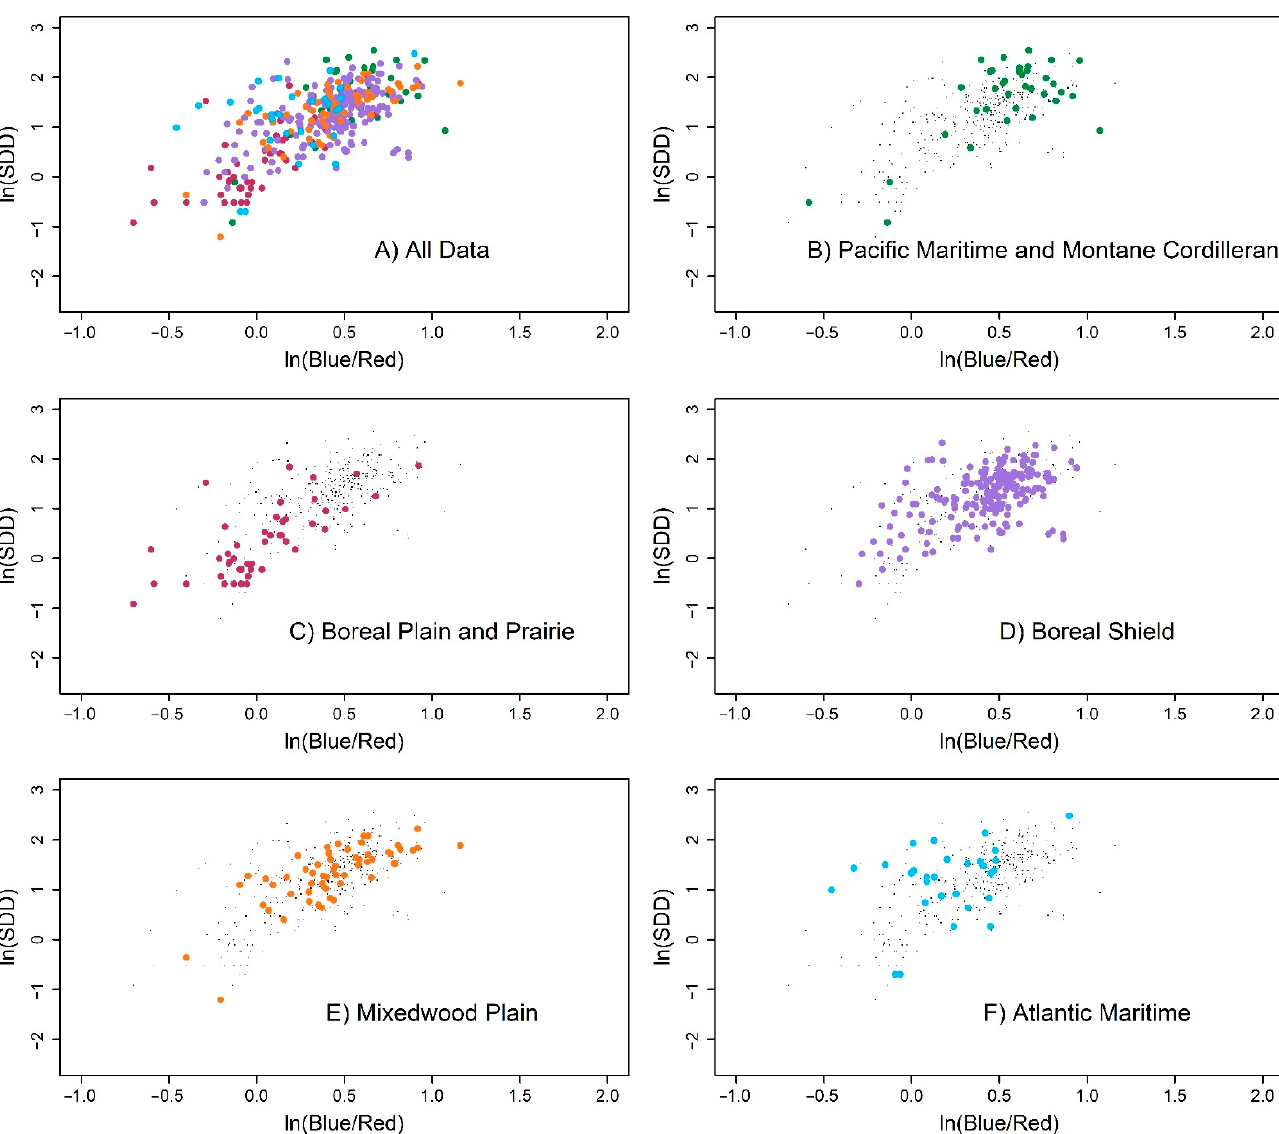
Figure 4. Using a one-day temporal window between the data of in situ sample and the date of satellite overpass: scatterplots of ln(SDD) versus ln(Blue/Red) for ( A ) all ecozones together, and ( B – F ) individual ecozones or ecozone groupings plotted in color over a grey cloud representing the complete dataset. Points are color-coded by ecozone, consistent with previous plots. Green represents the Pacific Maritime and Montane Cordilleran, maroon represents the Boreal Plain and Prairies, purple represents the Boreal Shield, orange represents the Mixed Wood Plains, and blue represents the Atlantic Maritime.